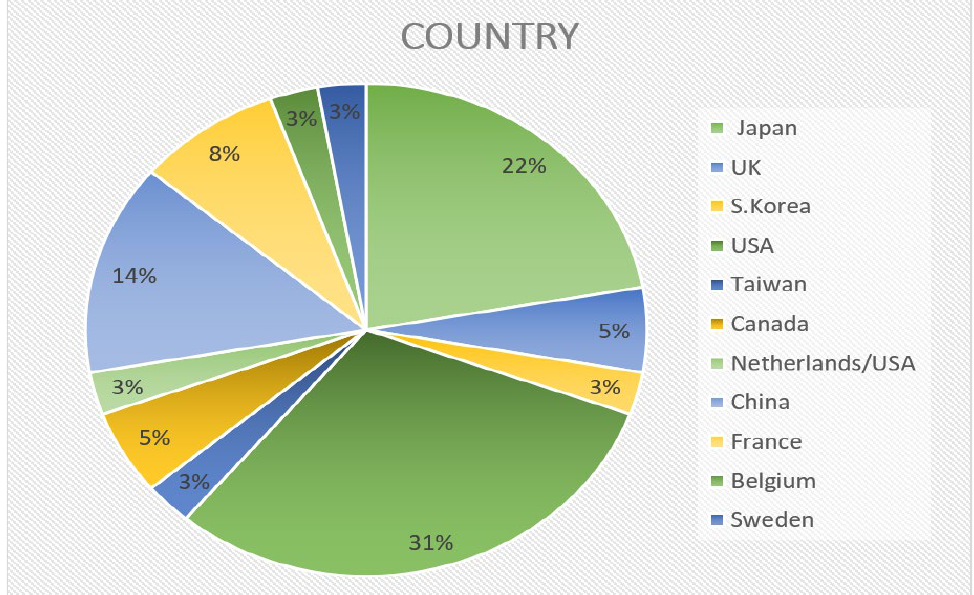
Figure 12. Pie chart of companies that claim to have an ASSB prototype or device based on their geographical position.